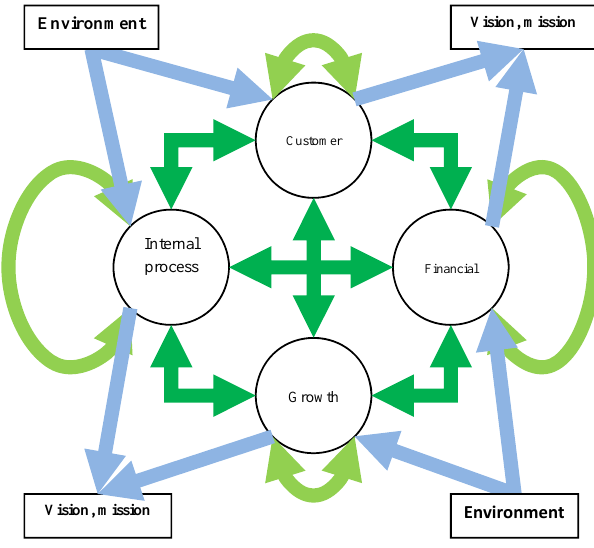
Fig.1. Relationships among different aspects of